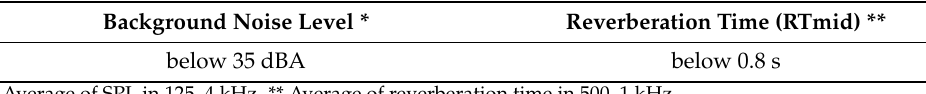
Table 10. Acoustical standard of Korean classrooms (example).